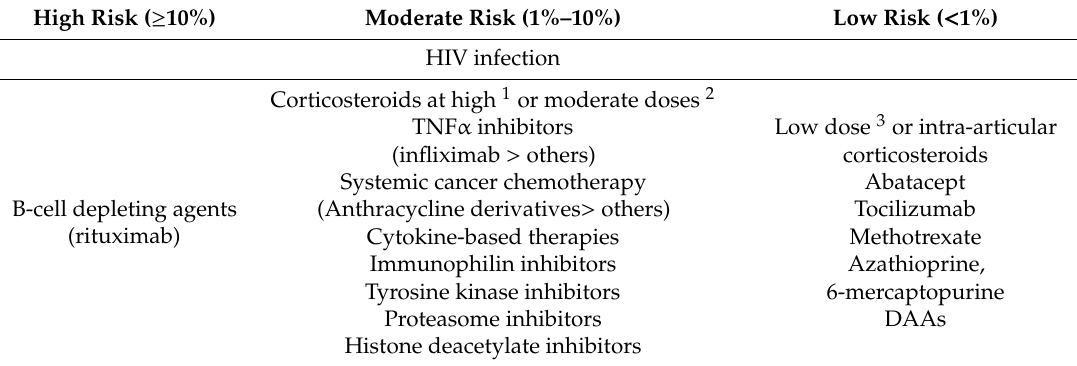
Table 2. Classification of IAHBc patients according to the risk of HBV reactivation.